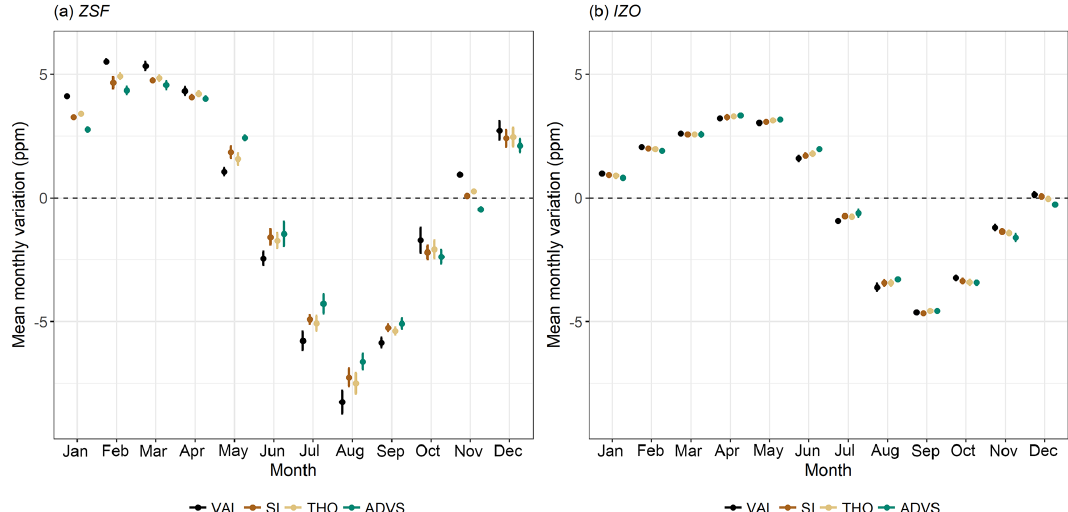
Figure 5. Mean monthly variation of the seasonal component decomposed by STL at (a) ZSF and (b) IZO over the whole period. For a better visualization of the results of selection methods, dots have been separated horizontally and equidistantly. The 95% confidence intervals are shown as error bars.